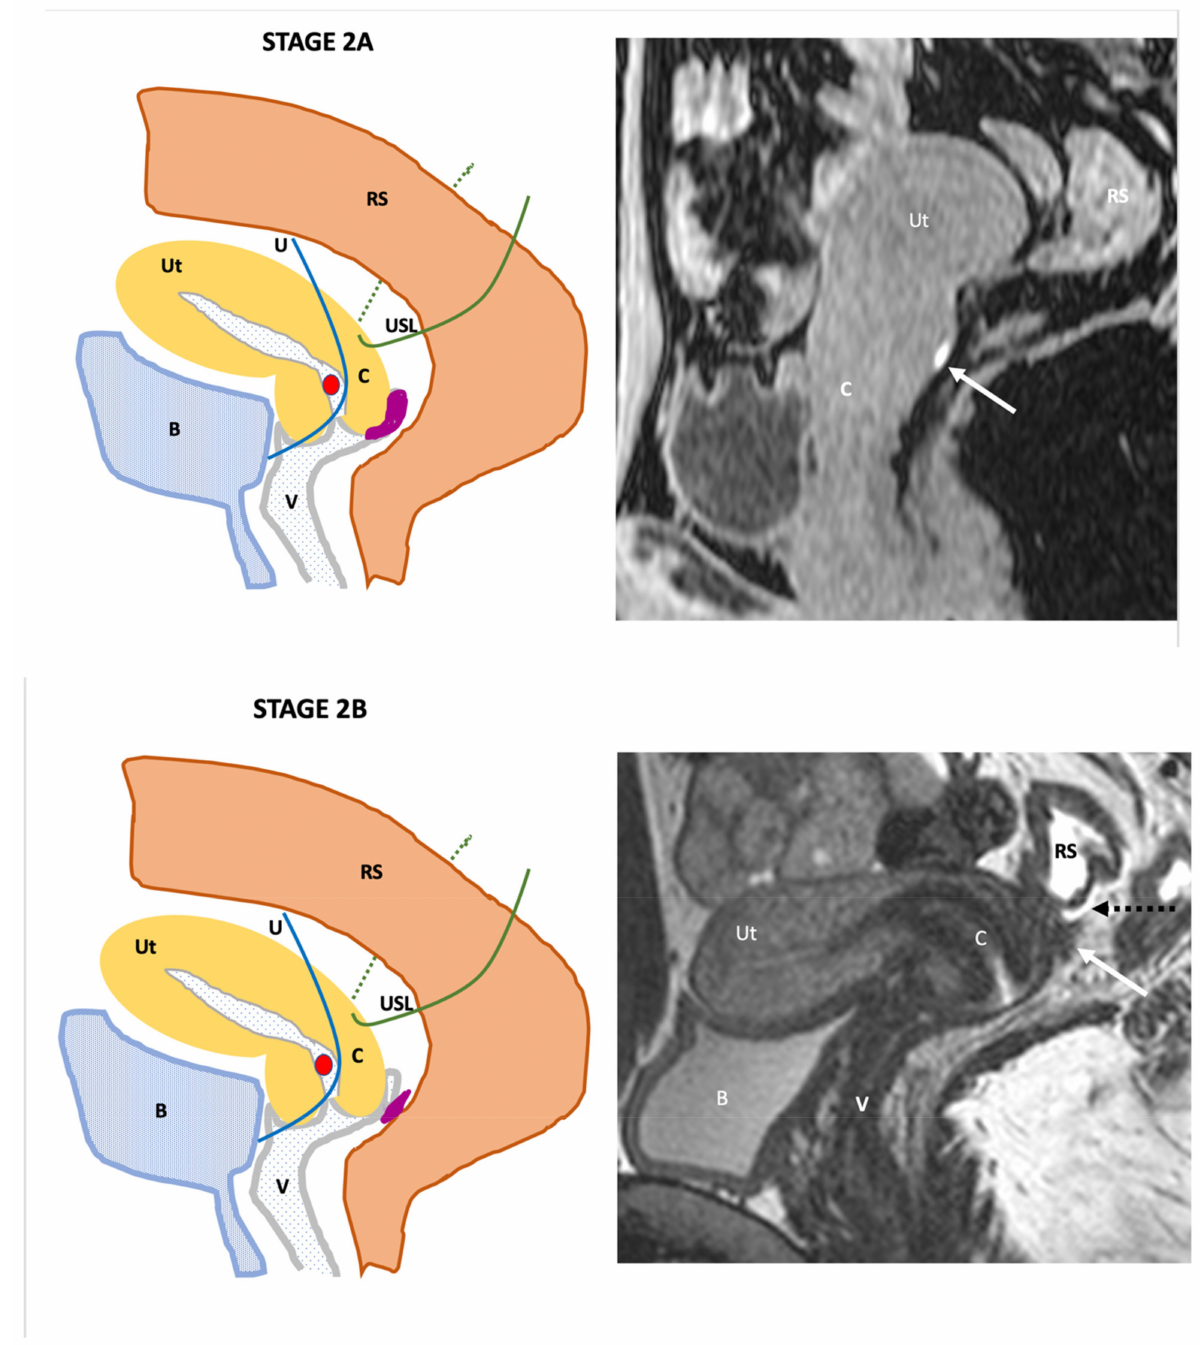
Figure 3. Schematic and example of stage IIA Endo-Stage MRI classification showing the presence of a localized regular thickening of the posterior vaginal wall (arrow) containing high signal intensity on a T1-weighted MRI (arrow). Schematic and example of stage IIB Endo-Stage MRI classification showing the presence of an irregular thickening of rectovaginal septum (arrow) with low signal intensity on a T2-weighted MRI located just below a small amount of pelvic fluid located in the pouch of Douglas (dotted black arrow). Note: ( B ): bladder, ( C ): cervix, ( RS ): rectosigmoid colon, ( U ): ureter, ( USL ): uterosacral ligament, ( Ut ): uterus; red point: uterine artery, ( V ): vagina. Stage III : refers to parametrial (Stage 3A), sacro-recto-genital septum (3B) or lateral pelvic wall (Stage 3C) disease (Figure